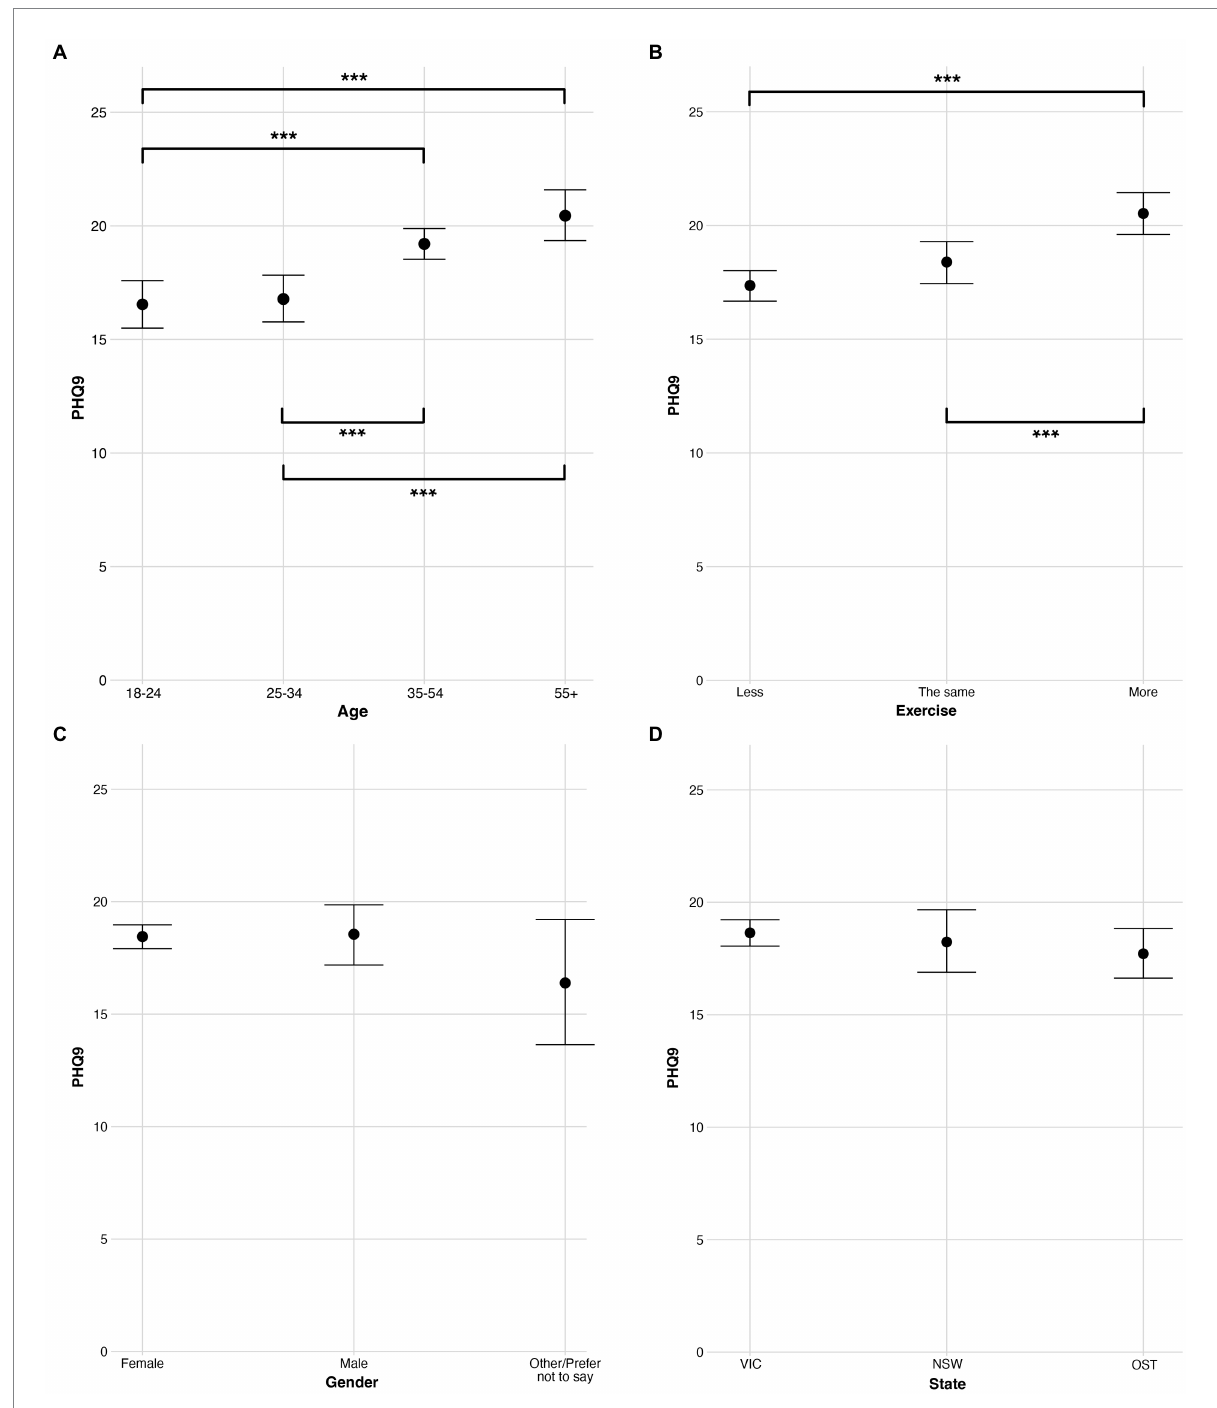
FIGURE 4 Ratings of PHQ9 (depression) split across levels of the independent variables (A) age, (B) exercise, (C) gender, and (D) state. Error bars are 95% Bayesian credibility intervals. Additionally, evidence ratios 39–60 are denoted with *, evidence ratios 61–90 are denoted with **, and evidence ratios >90 are denoted with